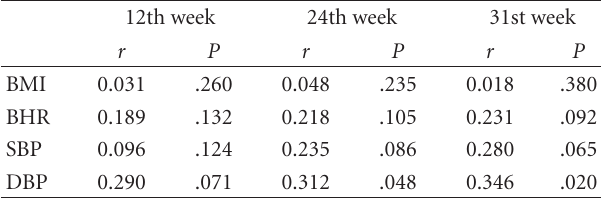
Table 8: Correlation of LF-HF ratio with body mass index (BMI), basal heart rate (HR), systolic blood pressure (SBP), and diastolic blood pressure (DBP) of subjects of study group I at di ff erent weeks of